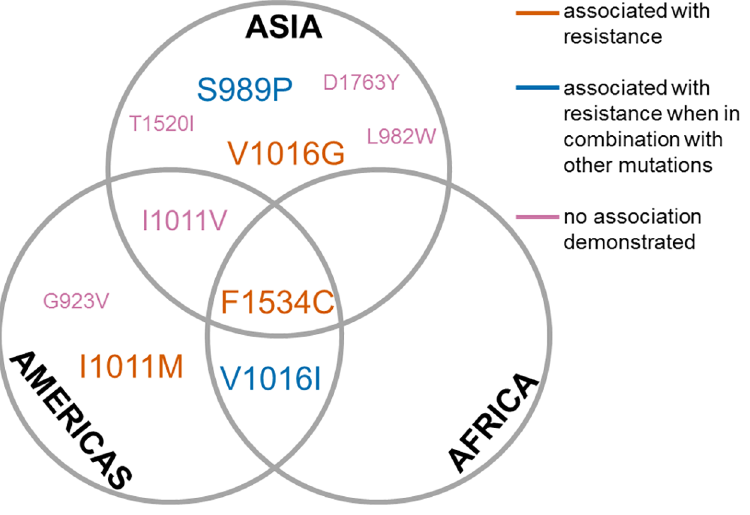
Fig 5. The geographical distribution of the 10 known voltage-gated sodium channel (VGSC) mutations in Aedes aegypti across the 3 continents in which they have been detected. Associationof each mutation with pyrethroid resistance is shown in the key. Font size gives an indicationof relative